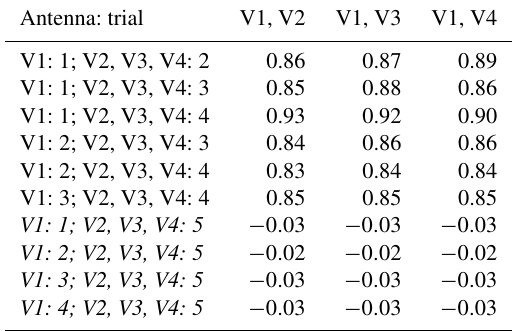
Table 5. Mean values of the real part of the complex correlation coefficients over frequency for different antenna pairs. The first col- umn indicates from which measurement trial the measured sample sequences of the specified antenna originate.